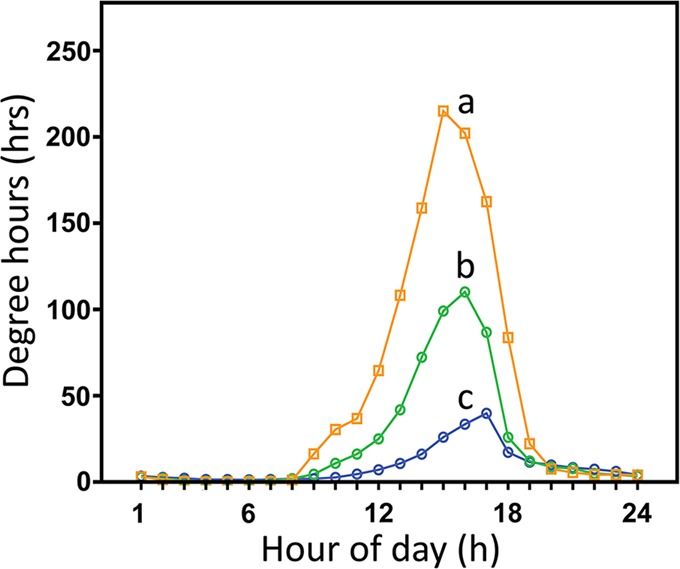
Degree-hours values at Crystal Cove State Park. Degree-hours over a 30-day interval beginning September 1, 2013 at three microhabitats including low-shore-wave-exposed, diamonds; high-shore-wave-exposed, circles; and high-shore-sheltered, squares. ANOVA was significant, P<0.05, for effects of micro-site on mean degree-hours above 19°C. Letters represent homogenous sites.